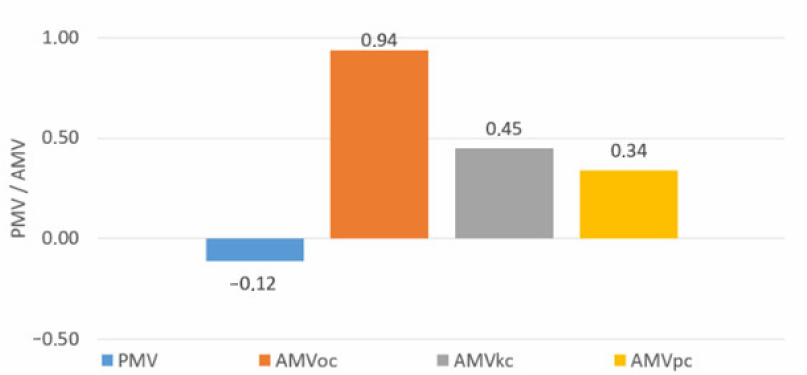
Figure 2. The predicted mean value of thermal conditions according to PMV vs. actual mean value of thermal conditions according to patients’ thermal sensations (AMVoc), thermal comfort feelings (AMVkc), and thermal preferences